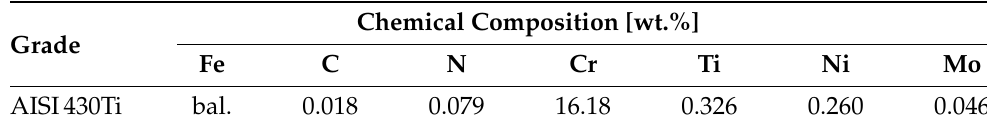
Table 1. Chemical composition of AISI430Ti sheet material [25].